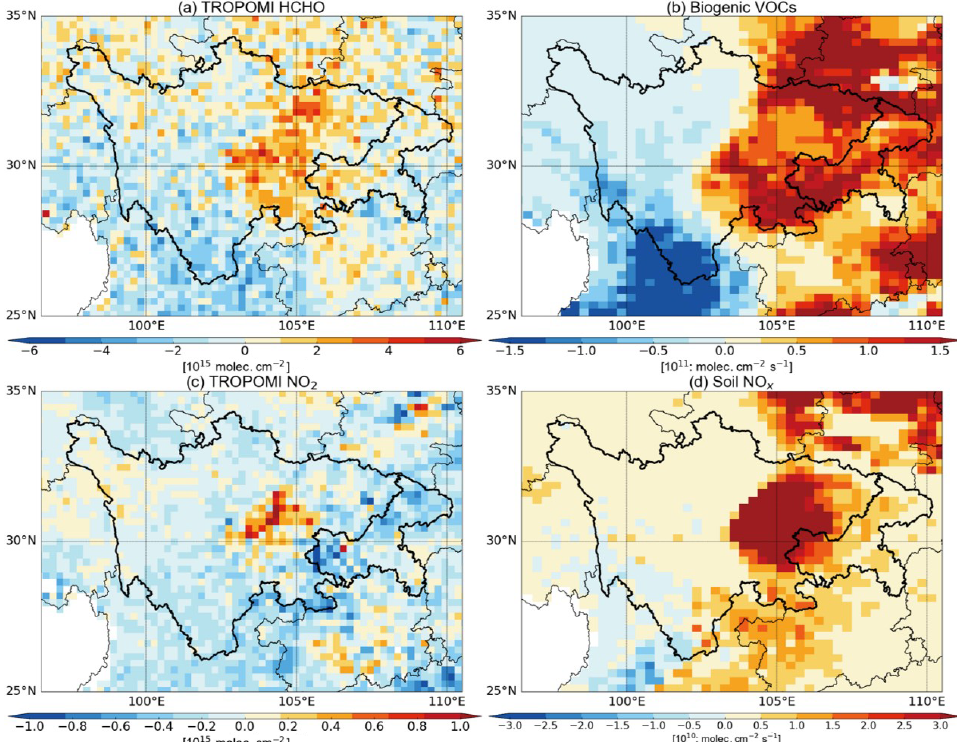
Figure 7. May–June mean differences in O 3 precursors between 2020 and 2019: (a) TROPOMI-observed HCHO, (b) biogenic VOCs, (c) TROPOMI-observed NO 2 , and (d) soil NO x . Biogenic VOCs and soil NO x are available from GEOS-Chem model online calculations. The base map of the figure was created using the Basemap package in